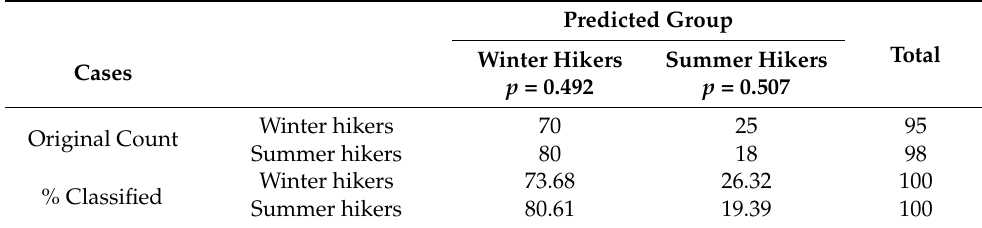
Table 4. Classification results of the winter and the summer hikers.